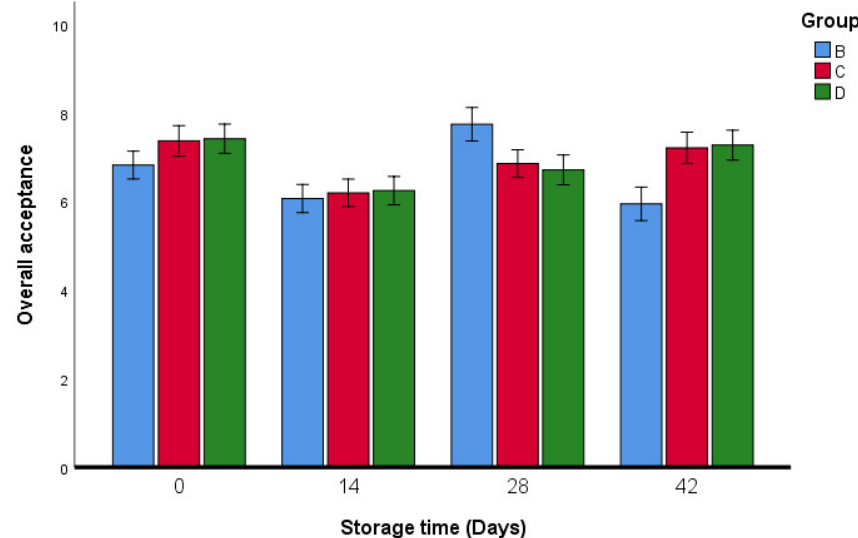
Figure 14. Overall acceptance sensory analysis of fresh oregano during storage period (42 days).